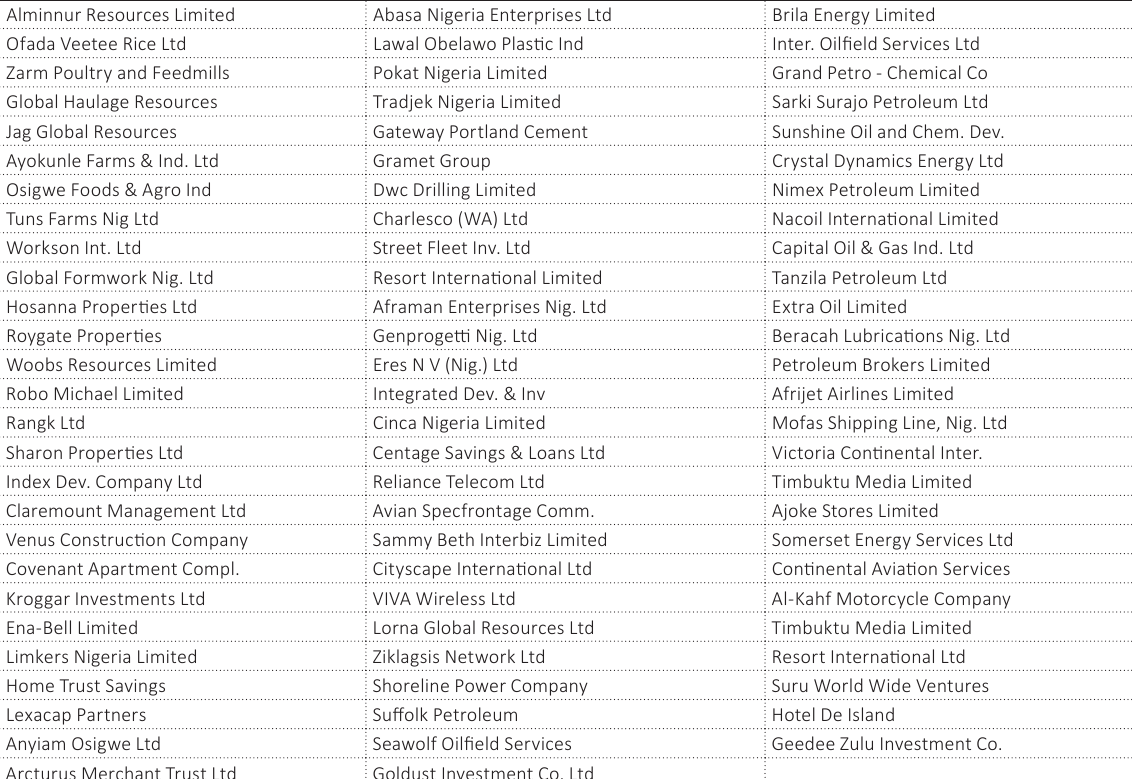
Table A5. List of sampled companies Source: AMCON (2016), Bloomberg website, official websites of the sampled